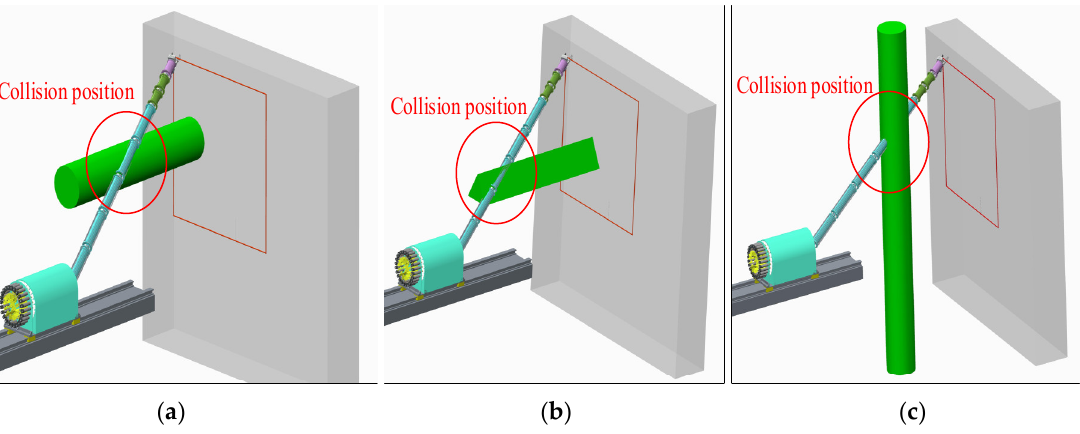
Figure 5. Three kinds of obstacle models and collision scenarios. ( a ) Obs1: first obstacle; ( b ) Obs2: second obstacle; ( c ) Obs3: third obstacle.